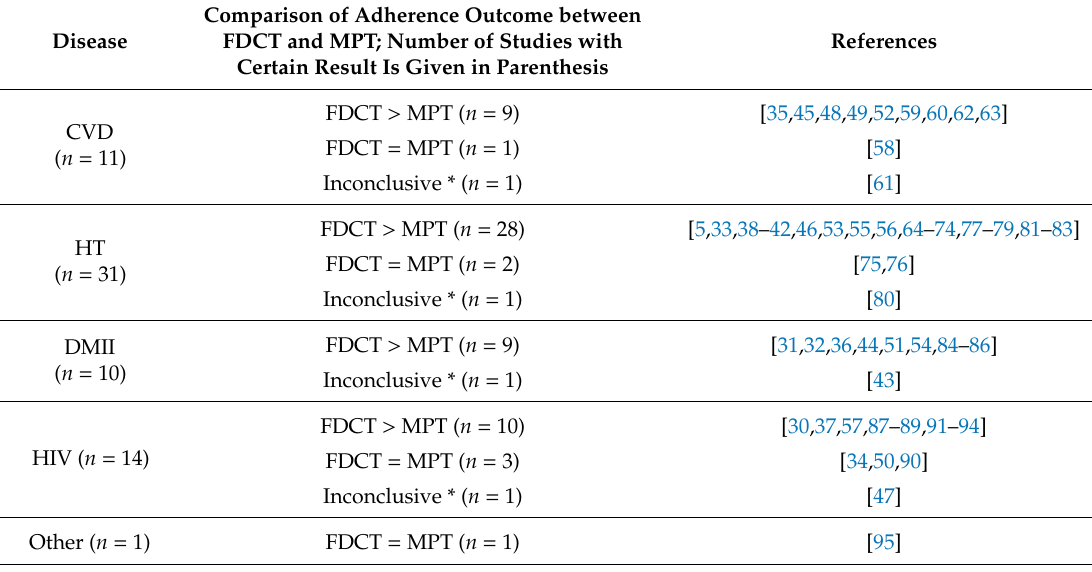
Table 5. Summary of the study results per disease. Statistically significant di ff erences in adherence outcomes are presented and